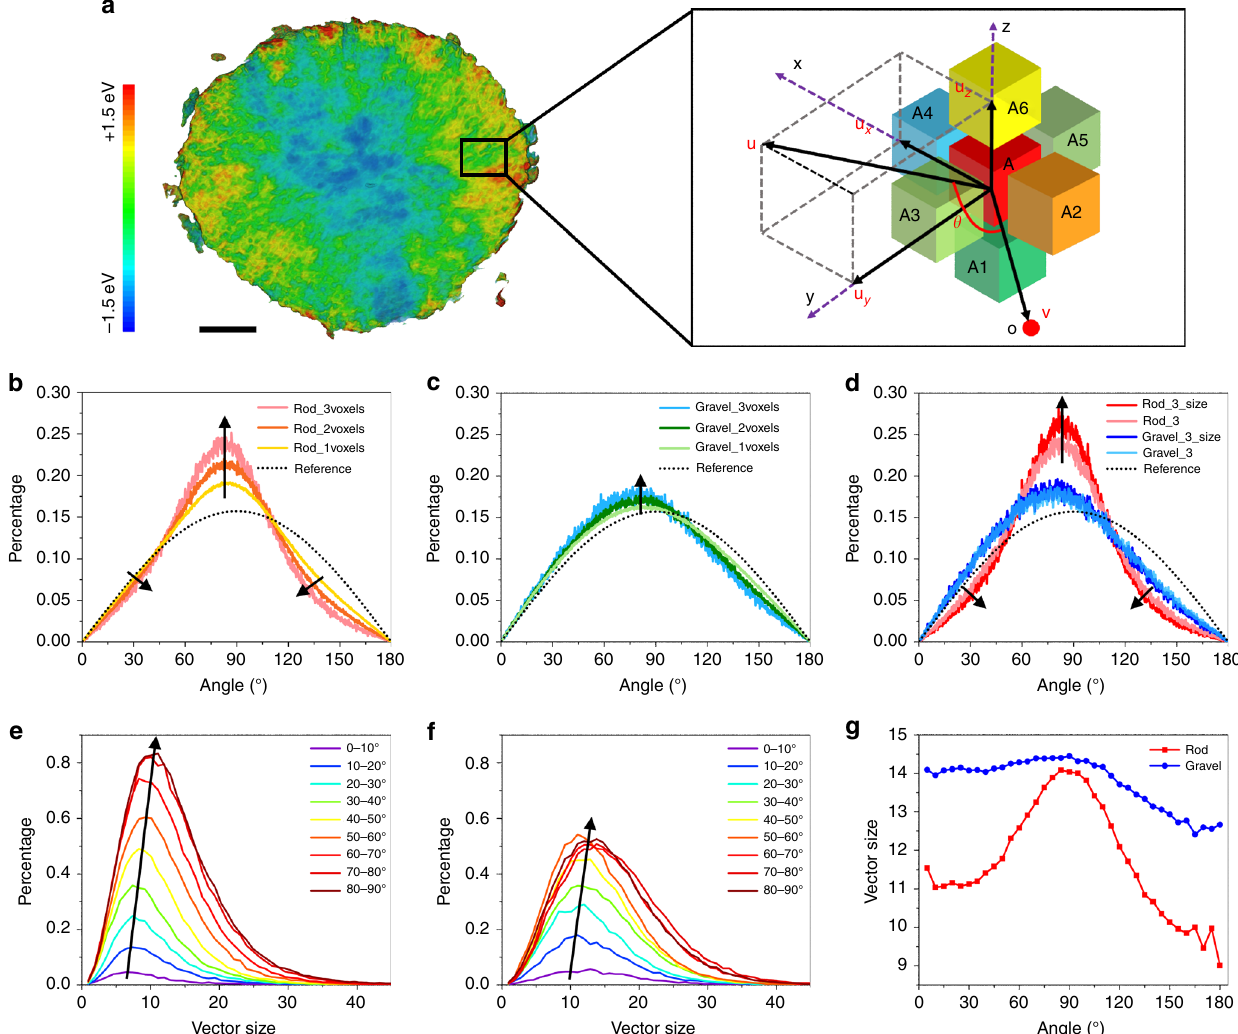
Fig. 4 Quantitative analysis of the charge distributions. a Schematic illustration of the valence gradient model used to analyze the 3D distribution of Ni valence states. The left side is a cross-section image of the 3D TXM, in which the relative local Ni K-edge absorption energy are color-coded to illustrate the spatial variation of the Ni valence state. The vector angle θ distributions of b rod-NMC and c gravel-NMC as a function of voxel size. d The vector angle θ distributions of rod- and gravel-NMCs before and after considering the vector size. Rod_3 and Gravel_3 in ( d ) correspond to the Rod_3voxels and Gravel_3voxels in ( b ) and ( c ), respectively. Rod_3_size and Gravel_3_size in ( d ) are the results after considering the vector sizes. The dashed black lines in ( b – d ) represent the reference data as explained in Supplementary Fig. 13. The valence gradient vector size distributions in different θ ranges of e rod-NMC and f gravel-NMC. g The average valence gradient vector size as a function of θ where 0° – 180° were divided to 36 intervals. The scale bar in ( a ) is 2 μ